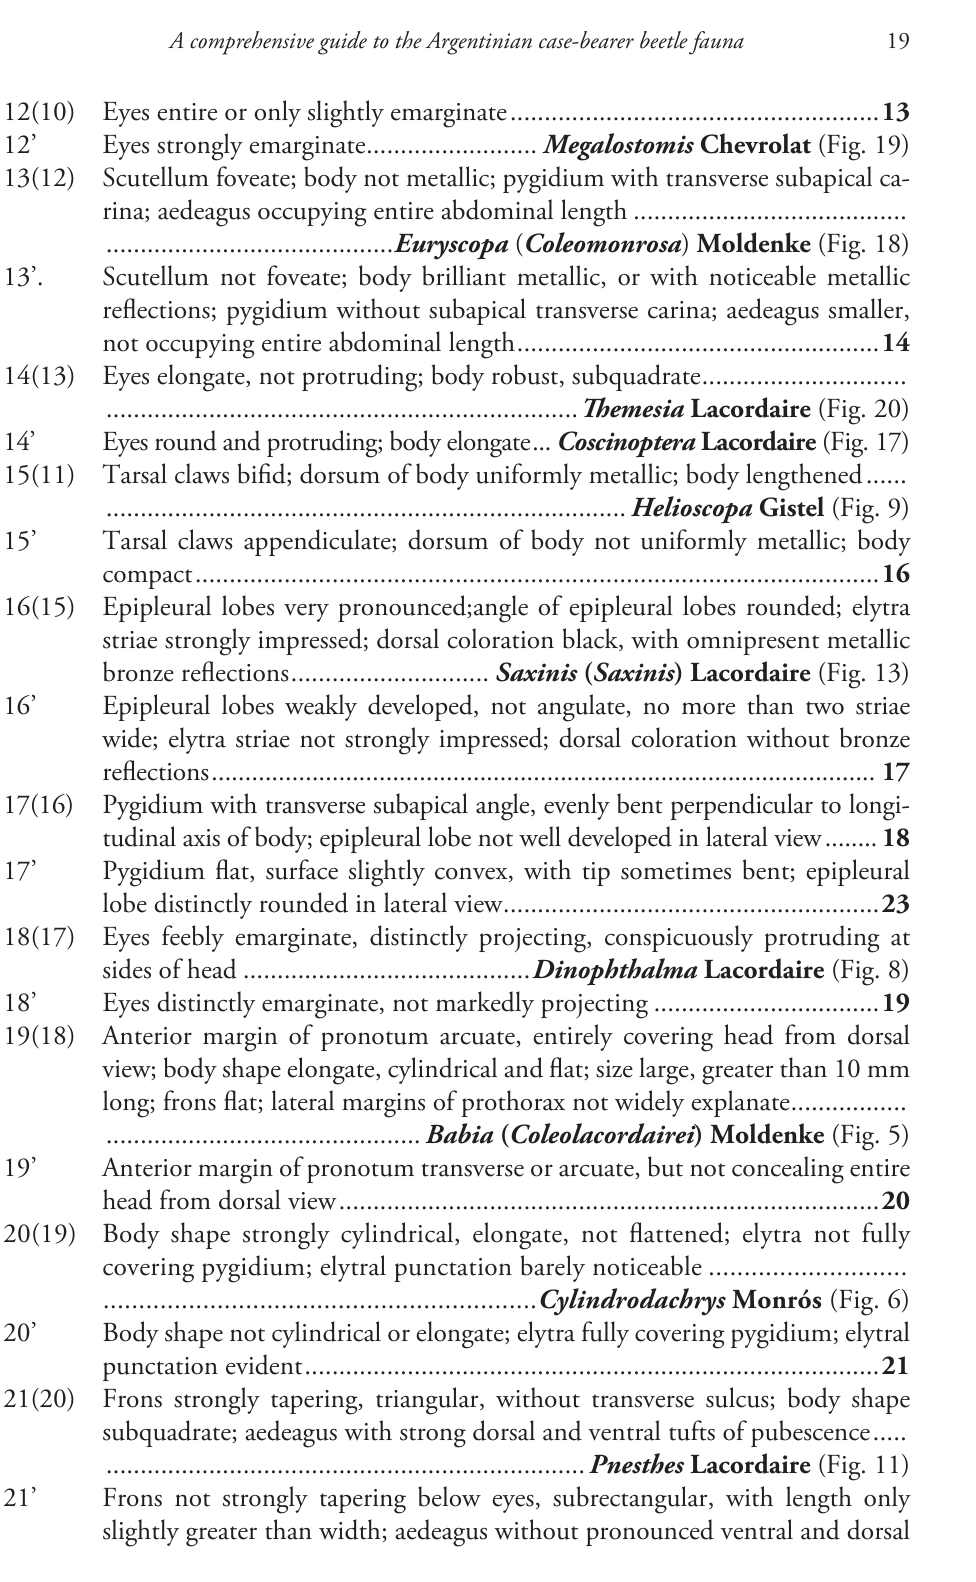
Scutellum foveate; body not metallic; pygidium with transverse subapical ca-